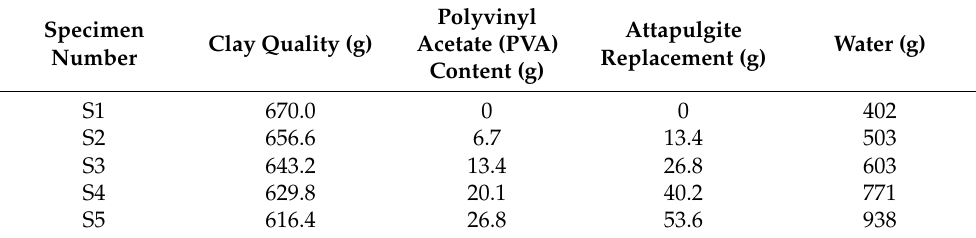
Table 1. Vegetation growth test